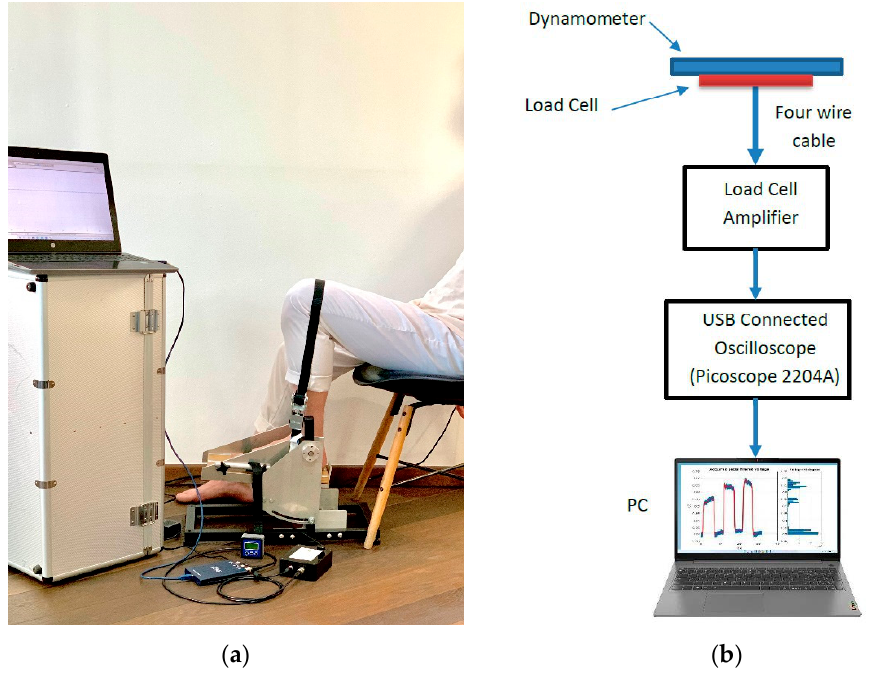
Figure 1. Representation of the measurement system set-up; ( a ) measurement system layout comprising of custom-made electronic dynamometer with incorporated load cell and hardware components: oscilloscope, load cell amplifier, electronic inclinometer, connective wires and personal computer (PC). The installation of the whole measurement system including participant chair demonstrates the reduced required space (approx. 2 m 2 ); ( b ) a complete diagram of the measurement system components representing the hardware elements used as graphics: portable, custom-made electronic dynamometer for ankle torque assessment with incorporated load cell, load cell amplifier, oscilloscope, connecting wires, personal computer.